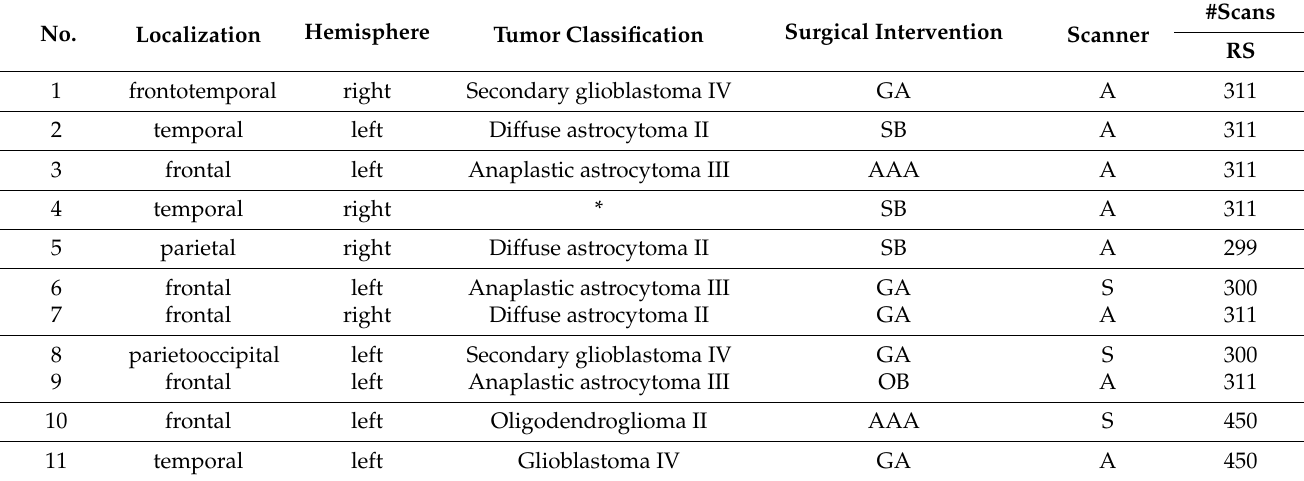
Table 1. This table describes the parameters of the patient sample in this study. The first column shows the patient number (No.); the second column depicts the tumor localization (Localization) and the third column the side of the lesion (Hemisphere); tumor classification (* no exact classification possible) is described in the fourth column and the type of surgical intervention (GA = craniotomy and tumor removal under general anesthesia, SB = stereotactic biopsy, AAA = craniotomy, and tumor removal using an awake-awake-awake-technique, OB = craniotomy and biopsy (open biopsy)) is described in the fifth column (** no surgery was performed); the Scanner column (number 6) shows whether patients were examined by means of an Allegra (A) or Skyra (S) MRI scanner. The number of scans obtained for each patient in the RS-fMRI session is shown in the seventh column (#Scans